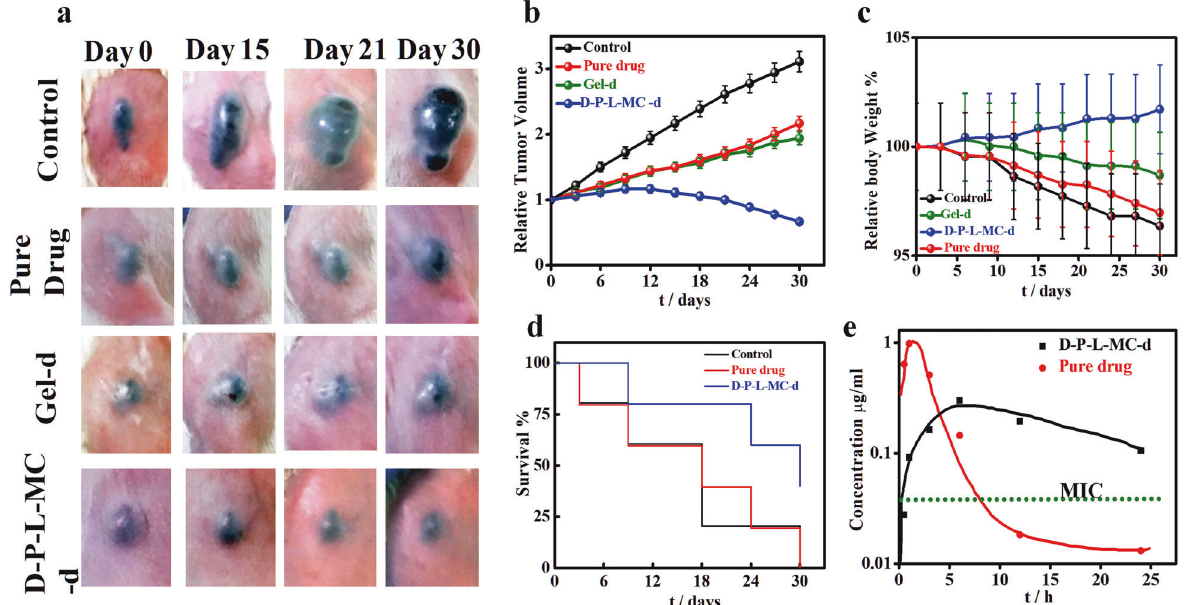
Fig. 6 In vivo melanoma studies using mice. a Photographic images of mice tumor volume at zero and subsequent days of treatment with pure drug, Gel-d (durg in MC gel), D-P-L-MC-d (drug in brush MC conjugate) , and control (only saline). b Relative changes in tumor volume with time after treatment with different systems as indicated. c Relative body weight percentage across the treatment groups. d Kaplan – Meier curve of survival percentage of mice after treatment with different systems. e Drug concentration pro fi le in plasma as a function of time after intravenous administratrion of durg (5 mg/kg of mice weight) either pure drug and brush conjugated gel ( D-P-L-MC-d ) with equivalent amount of drug. The dotted line indicates the minimum inhibitory concentration (MIC) of dexamethasone